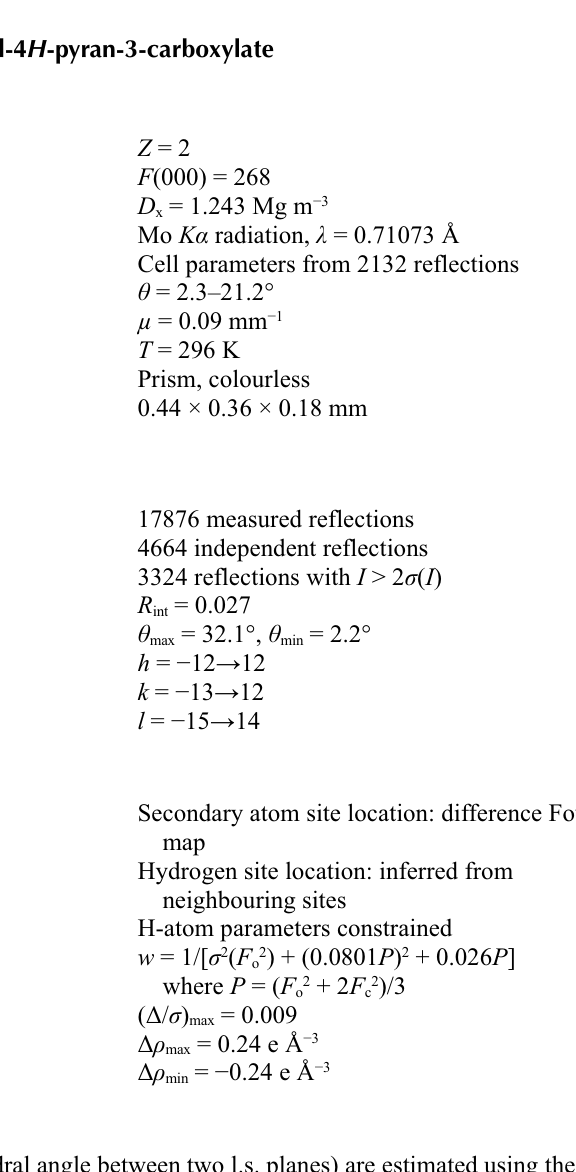
The formation of the title